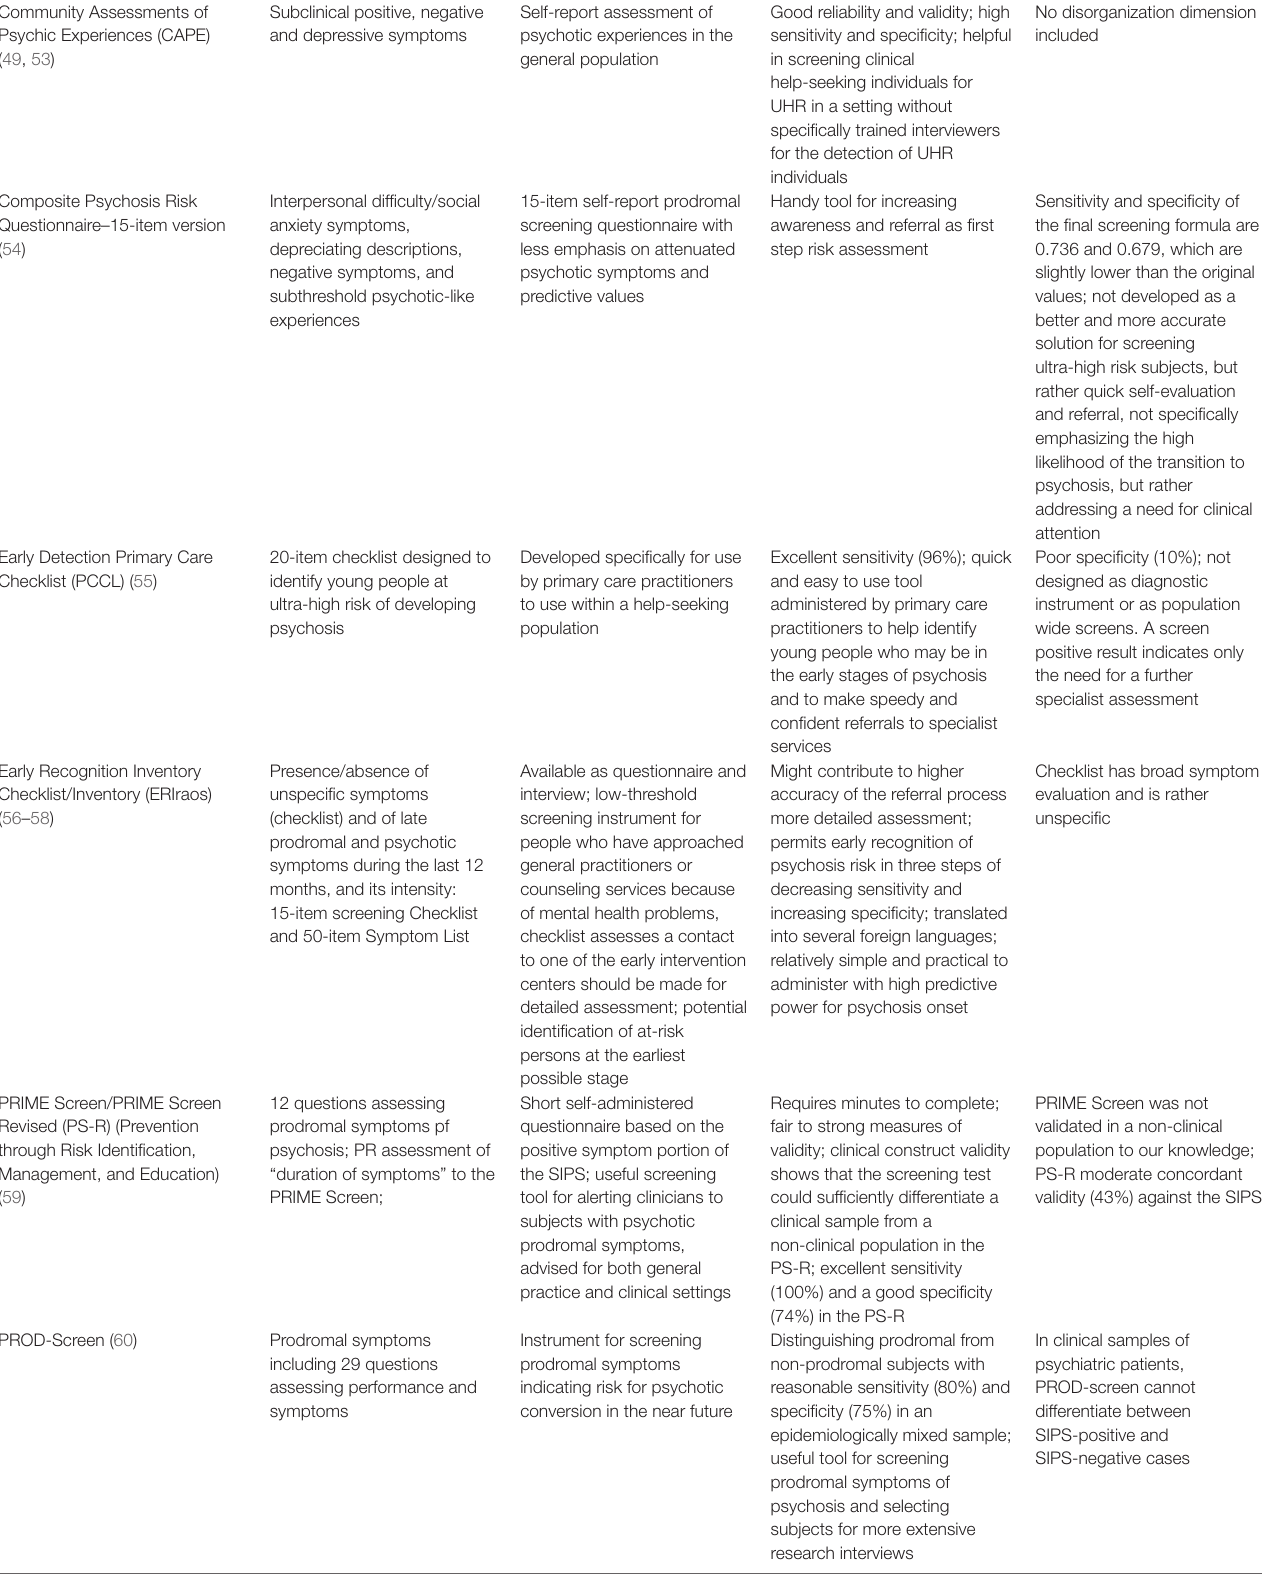
TABLE 1 | Screening instruments for psychotic-like experiences/psychosis/high risk for psychosis. Community Assessments of Psychic Experiences